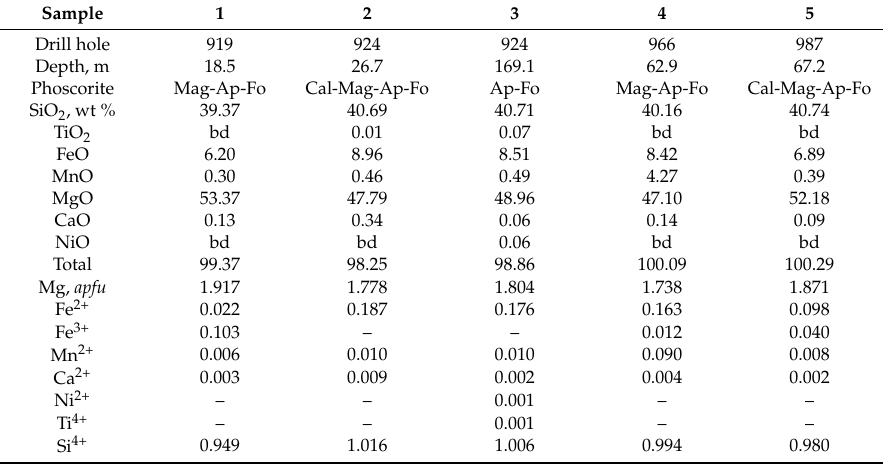
Table 5. Chemical composition of forsterite analyzed with single crystal X-ray diffraction.